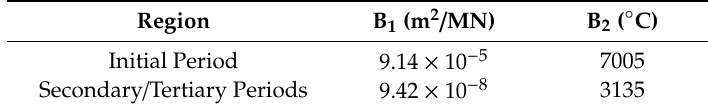
Table 4. Model constants for the calibrated equation based on two boundary